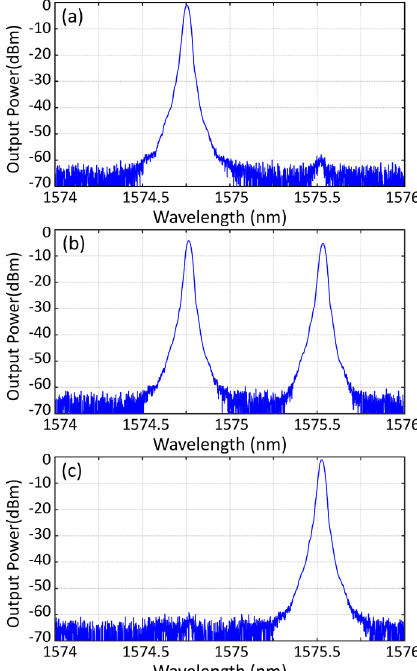
Fig. 3. Output spectra of the linear-cavity fiber laser when (a) single wavelength lasing centered at 1574.75 nm, (b) dual wavelength lasing centered at 1574.75 nm and 1575.75 nm, and (c) single wavelength lasing centered at 1575.5 nm are